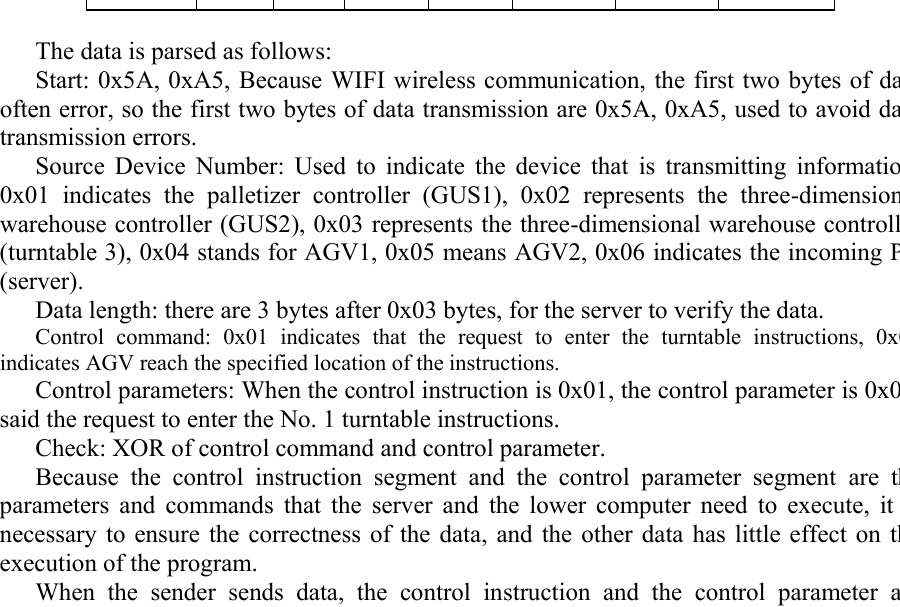
Fig. 3. Location map of router